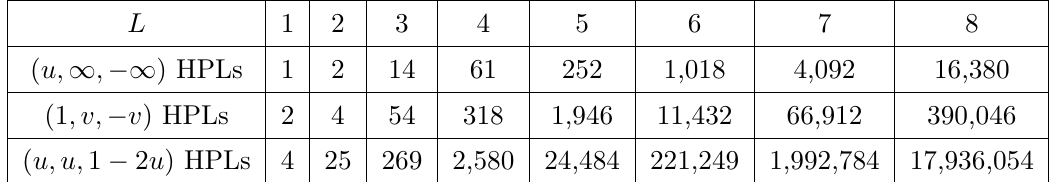
Table 7. The number of distinct HPLs at symbol level that appear in the expression for E on three lines: ( u, ∞ , −∞ ) , (1 , v, − v ) , and ( u, u, 1 − 2 u ) . The number depends some on which HPL argument is used; here we use 1 − 1 /u , 1 /v , and u ,